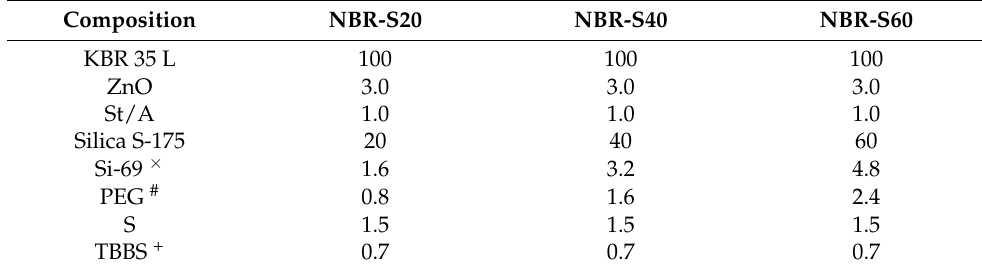
Table 2. Compositions of the NBR with silica fillers. Composition